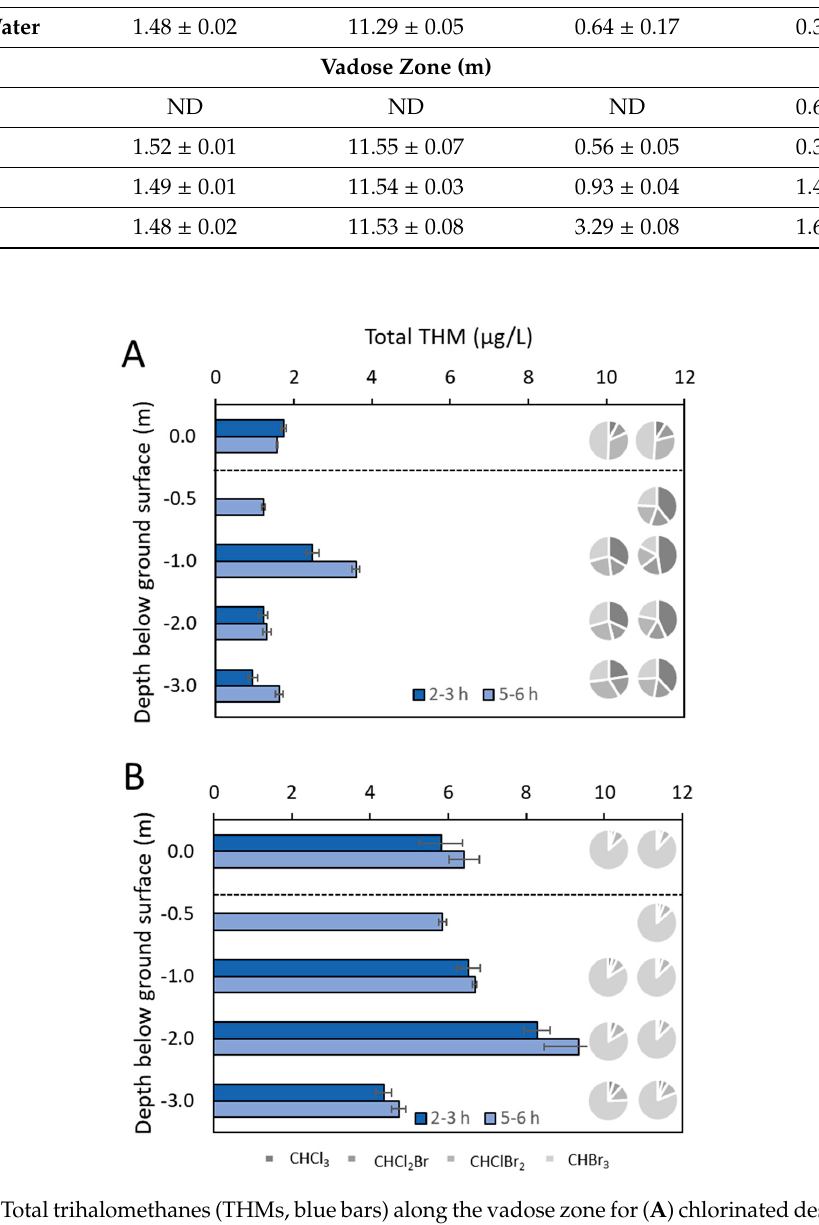
Table 2. Water parameters in the second controlled infiltration experiment with desalinated seawater spiked with bromide. DOC and bromide were analyzed for samples collected 2–3 h and 5–6 h after the infiltration began. Bromide was monitored hourly in the ponding water. (ND—No data.)